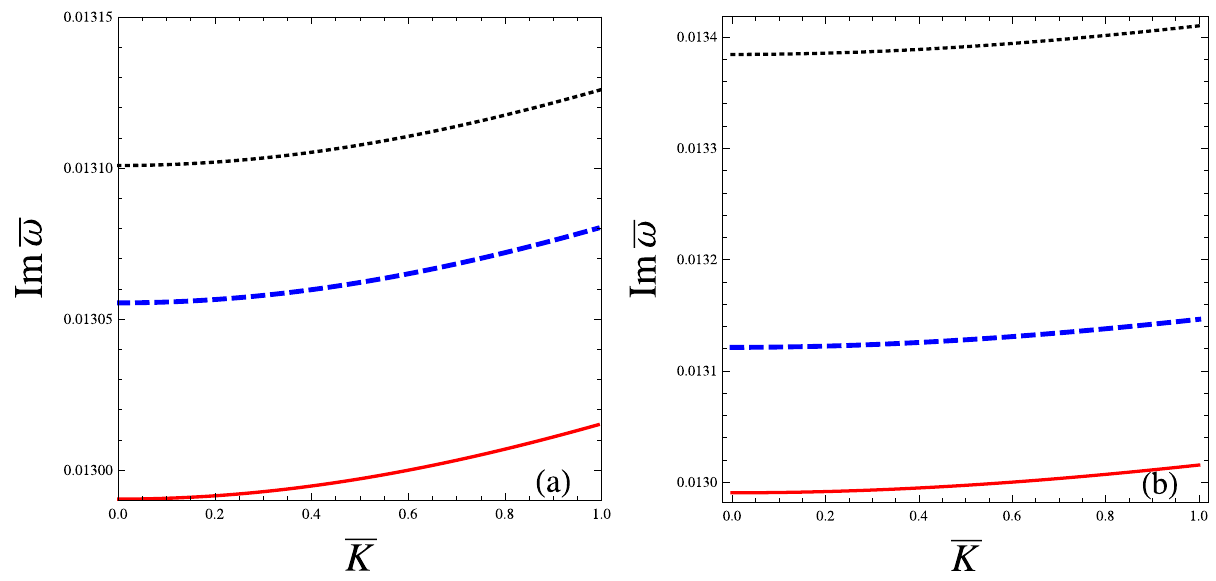
Figure 1. The dimensionless imaginary root Im against the dimensionless wavenumber ¯ K ( 10 3 cm s − 1 (solid curve), 2 U ( 0 ) = is depicted versing ¯ K when ( b ) magnetic field B ( 0 ) = 10 5 G (solid curve), 2 (dotted curve) when T c